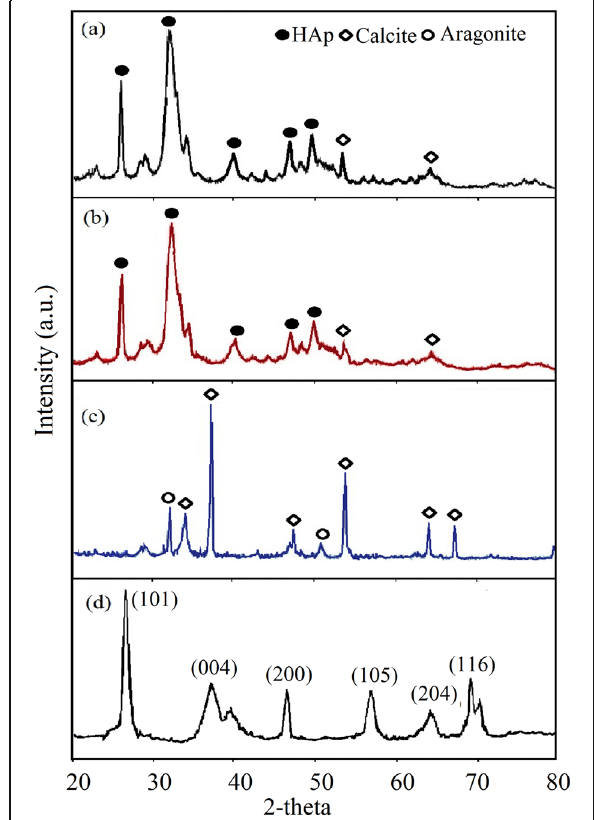
Fig. 2 XRD pattern of ( a ) HAp- n TiO 2 , ( b ) HAp, and ( c ) CaO derived from Cockle shell ( d ) nano-TiO